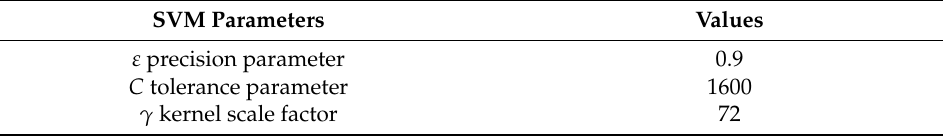
Table 1. SVM algorithm parameters.